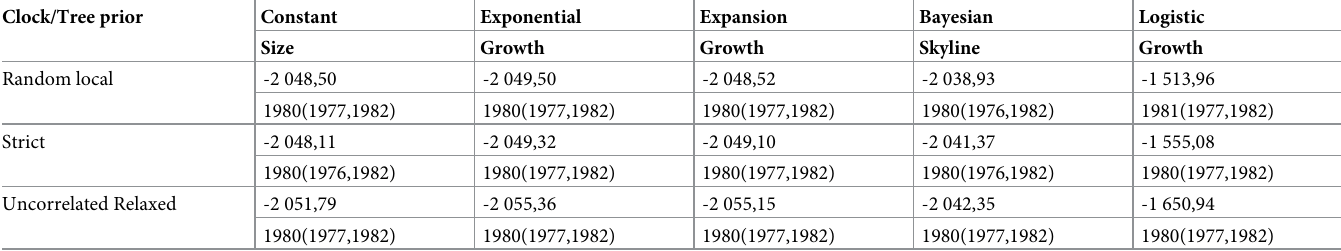
Table 2. Fitting models bayes factors and HPD95% related to RV-A101.